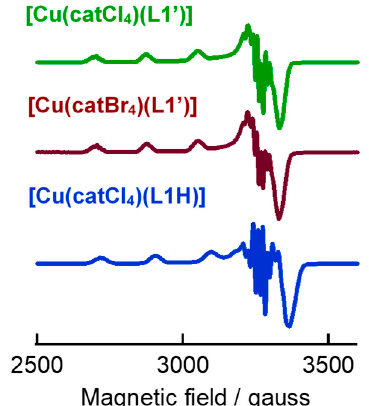
Figure 6. ESR spectra of [Cu(catCl 4 )(L1 ′ )] ( top ), [Cu(catBr 4 )(L1 ′ )] ( middle ), and [Cu(catCl 4 )(L1H)] ( bottom ) measured by CH 2 Cl 2 /C 2 H 4 Cl 2 solution at 137 K.